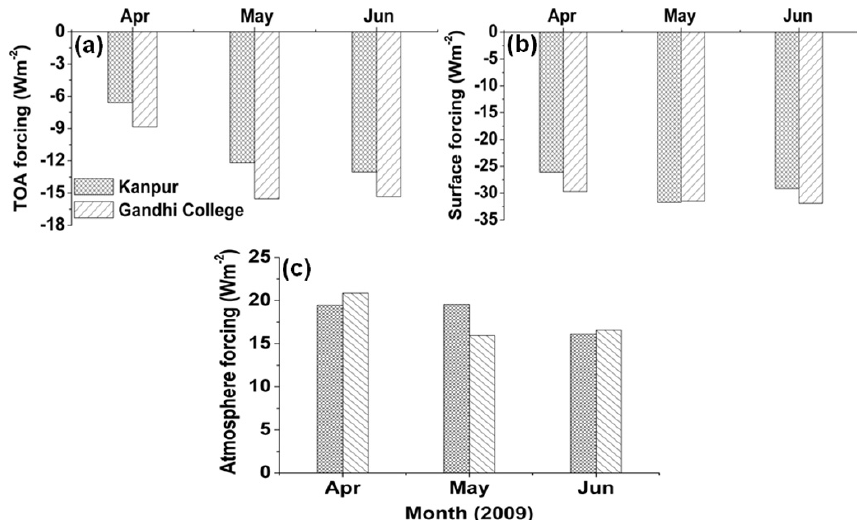
Fig. 9. Short-wave radiative forcing at (a) TOA, (b) surface and (c) in the atmosphere at Kanpur and Gandhi College during April to June